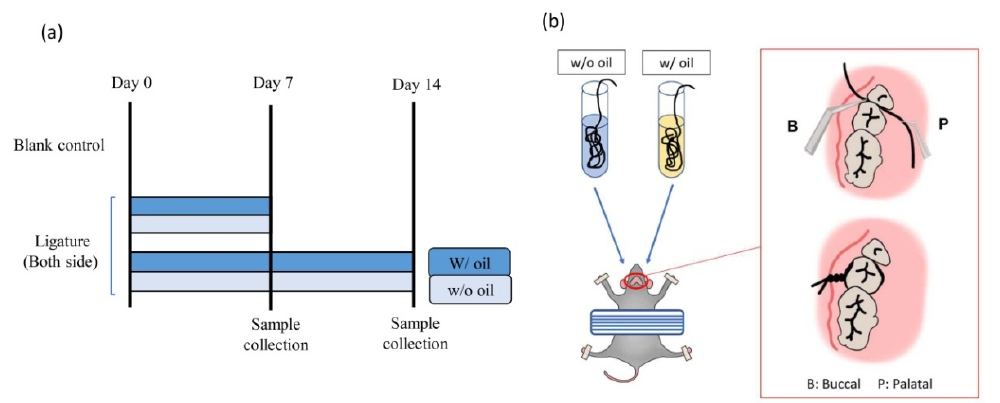
Figure 9. ( a ) Ligature-induced periodontitis experimental design with sacrifice time points. Blank control was the ligature-free samples at Day 0. In the ligature group, the second left molar was ligated with silk pre-immersed with SM oil (w/ oil). The corresponding tooth on the right side was tied with silk-free of SM oil (w/o oil) on Day 0. Rats were euthanized after 7 and 14 days. ( b ) Detailed procedures and preparation of the periodontitis animals were ligated with 3-0 silk around the cervical of the second molar of maxillary bone.